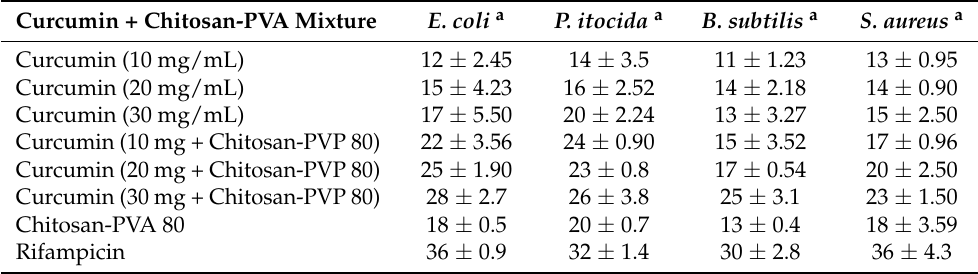
Table 3. Antibacterial screening using the agar disc diffusion method. Curcumin + Chitosan-PVA